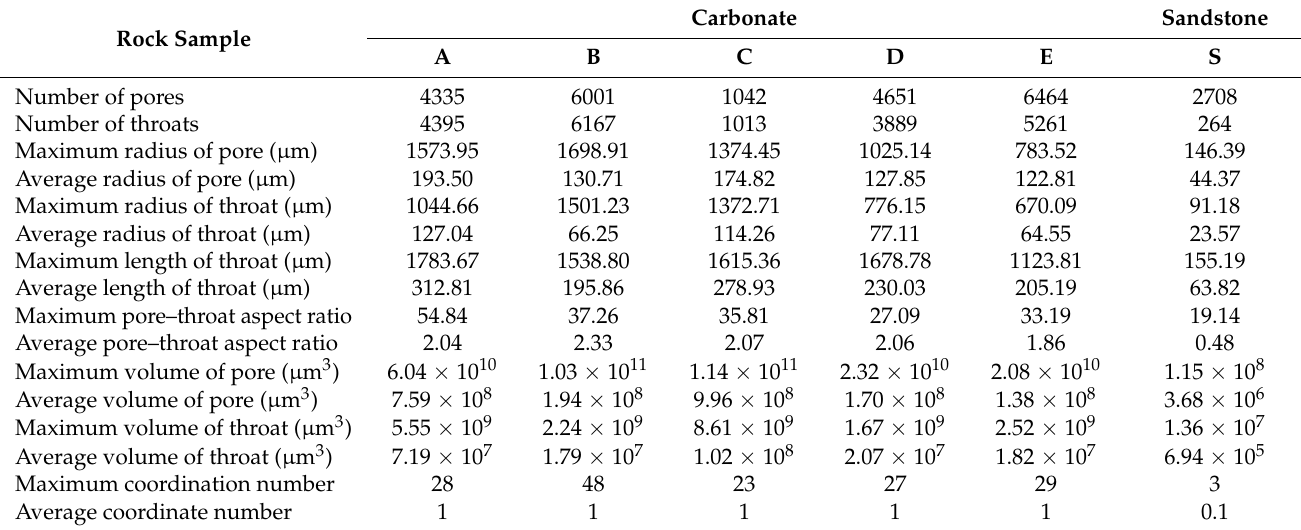
Table 4. Statistical results of pore network of REV2 of tested